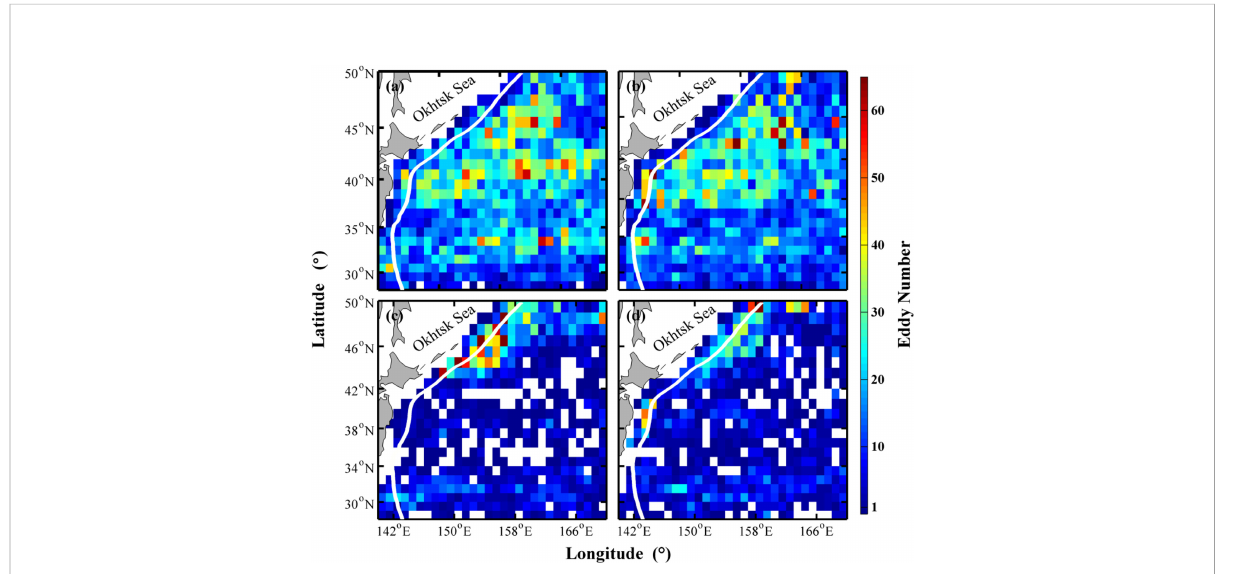
FIGURE 5 Spatial distribution of the four types of eddy numbers in 1° × 1° grids in the Kuroshio-Oyashio Extension region from January 3, 2008 – December 29, 2017. Subplots (A – D) give the cyclonic cold-core, anticyclonic warm-core, cyclonic warm-core, and anticyclonic cold-core eddies, respectively. Shading represents eddy number (areas with no eddies are shown in white). The bold white curve represents Japan and the Kuril-Kamchatka